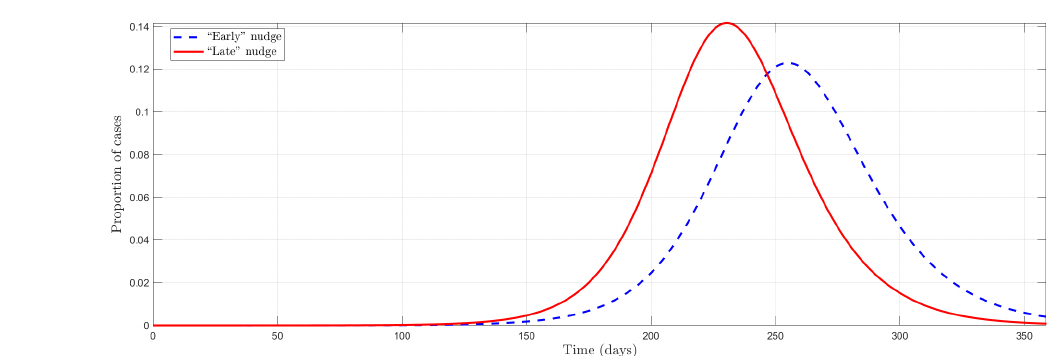
Figure 3. Timing effect in a nudge on social